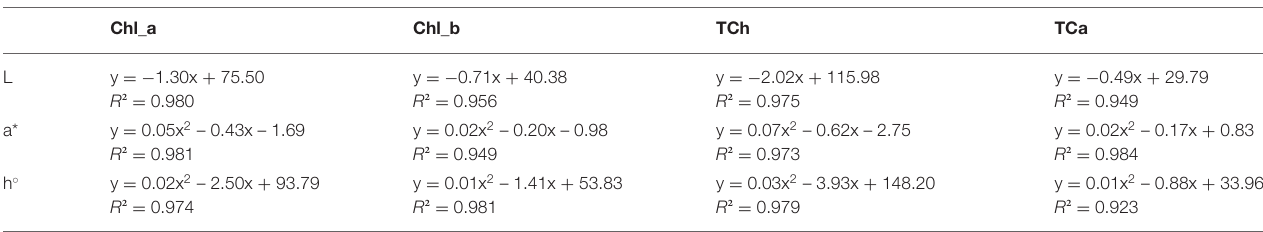
TABLE 6 | Regression results for color values vs. pigment content. Chl_a Chl_b TCh